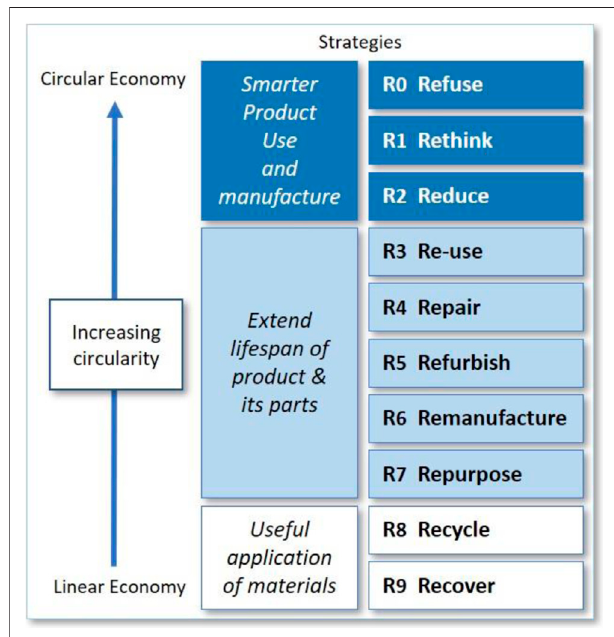
FIGURE 2 | Circularity strategies within the production chain, in order of priority. Adapted from Potting et al. (2017), fi g. 1, p. 5.